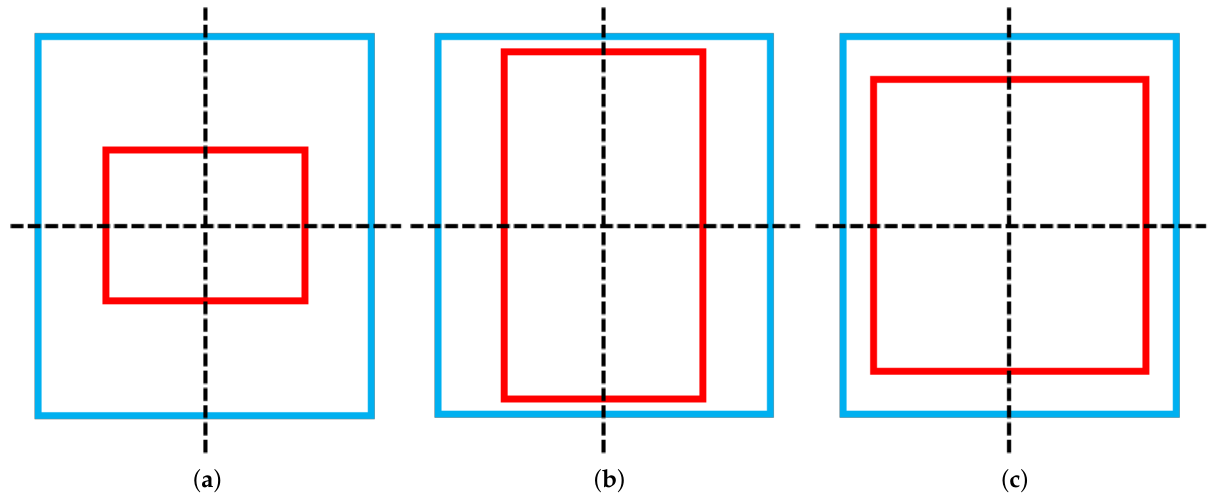
Figure 11. DIoU faces the case where one box is contained in another and the centroids of the two boxes coincide. ( a – c ) denote the cases where different B coincide with the centroid of the same B gt and B is contained inside B gt . Leads to the same result for